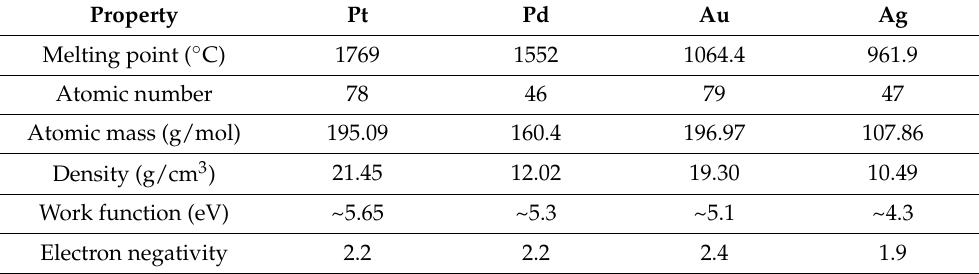
Table 1. Properties of some noble metals [118]. Reprinted with permission from Ref. [118]. Copyright 2015, Elsevier.